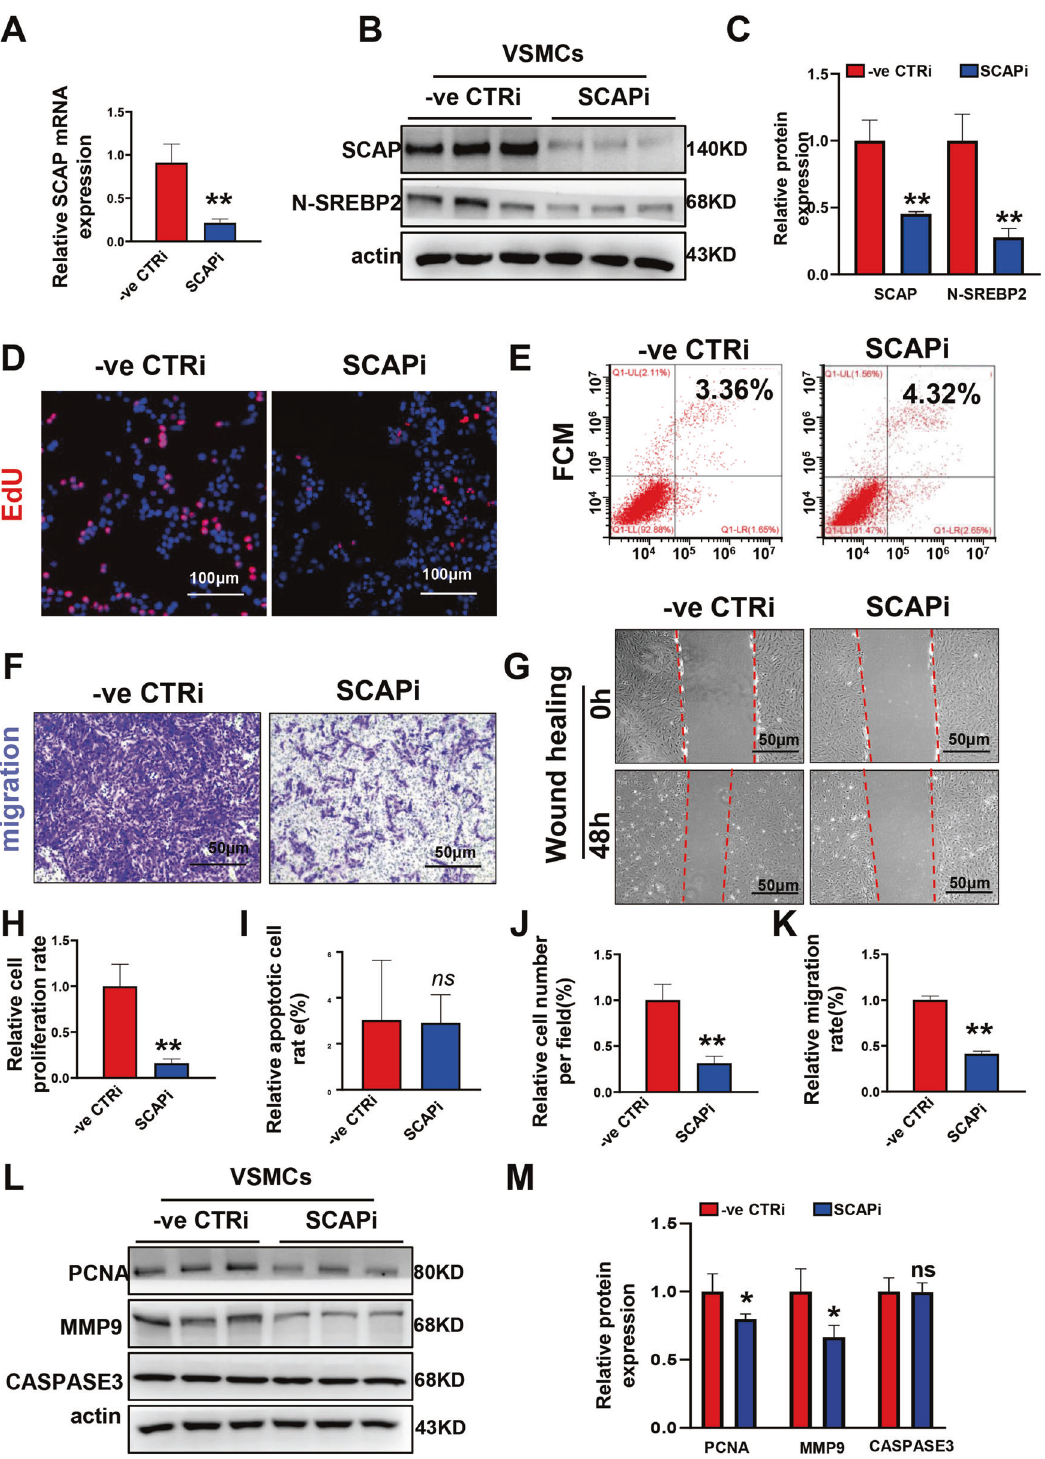
Fig. 3 Ablation of SCAP in VSMCs decreases VSMC proliferation and migration abilities in vitro. A Relative mRNA expression of SCAP in VSMCs transiently transfected with SCAPi or negative control small interfering RNA (-ve CTRi). B Immunoblot analysis of SCAP and N-SREBP2 protein expression in CTRi and SCAPi cells. C Quanti fi cation of the relative protein expression of ( B ). D Representative images of the EdU assay. Scale bar = 50 μ m. E Flow cytometry analysis of apoptosis in CTRi and SCAPi cells. F Representative images of the Transwell migration assay for each group. Scale bar = 50 μ m. G Representative images of wound-healing migration assays at 0 h and 48 h for each group. Scale bar = 50 μ m. H Statistical analysis of the relative cell proliferation rate in ( D ). I Statistical analysis of the relative apoptotic cell rate in ( E ). J Statistical analysis of the relative VSMC migration rate in ( F ). K Statistical analysis of the relative cell number per fi eld in ( G ). L Immunoblot analysis of PCNA, MMP9 and CASPASE3 protein expression levels in CTRi and SCAPi cells. M Quanti fi cation of the relative protein expression levels in ( L ). All experiments were repeated at least 3 times. Data are presented as the mean ± SD. * P < 0.05, ** P < 0.01, *** P < 0.001. P values were calculated by Student ’ s t test. Cell Death and Disease (2023)